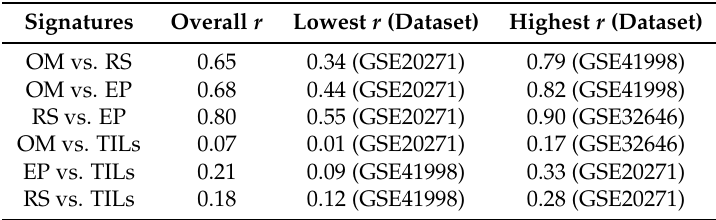
Table 2. Correlation coefficient r among the four signatures *